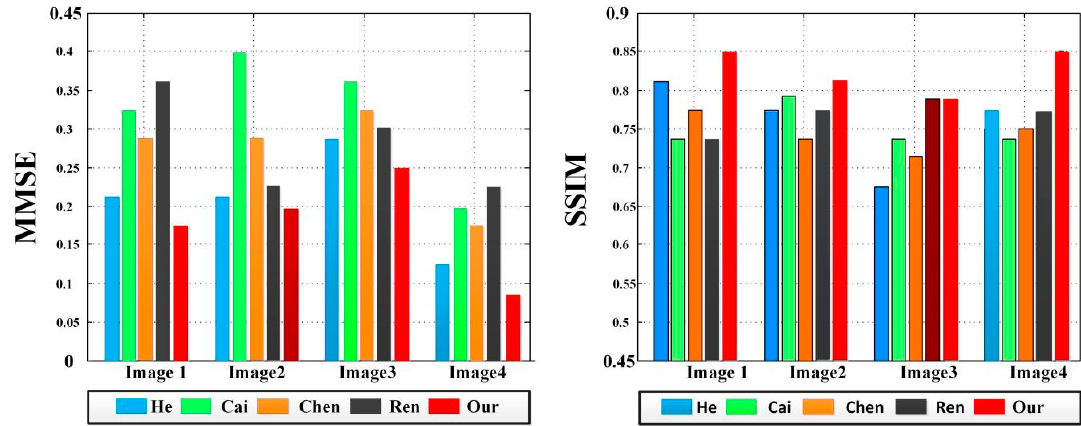
Figure 14. A comparison of MMSE and SSIM in Figure 13.